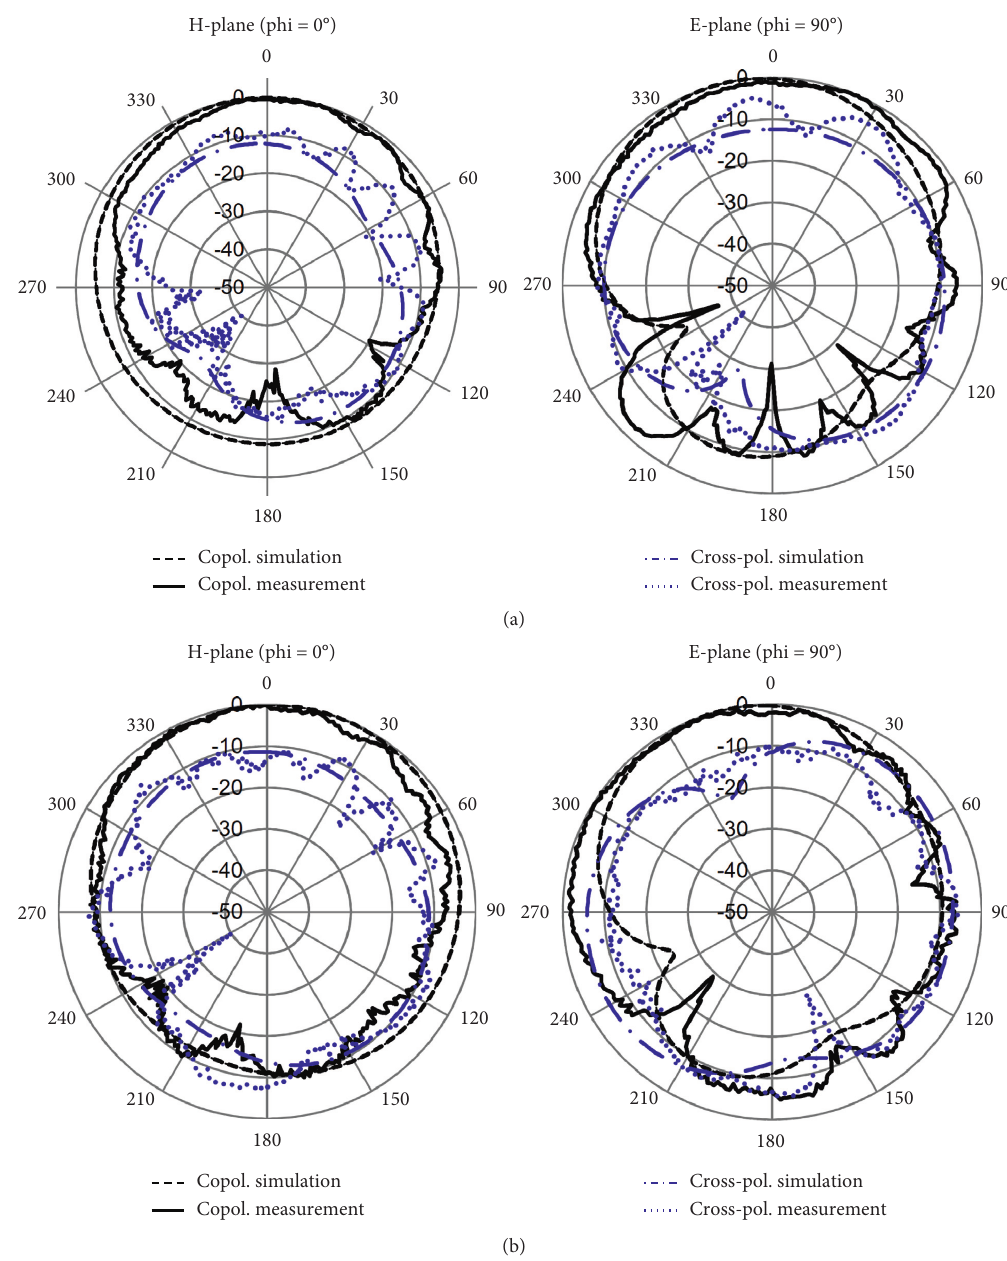
Figure 11: Simulation and measurement results of radiation patterns for (a) 3.72GHz and (b)